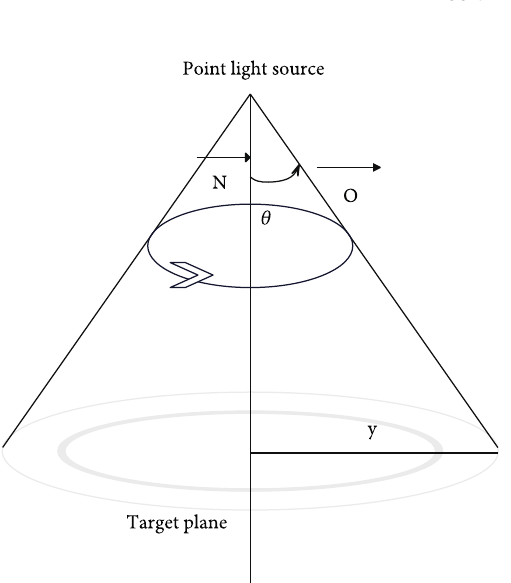
Figure 4: Refraction simulation.